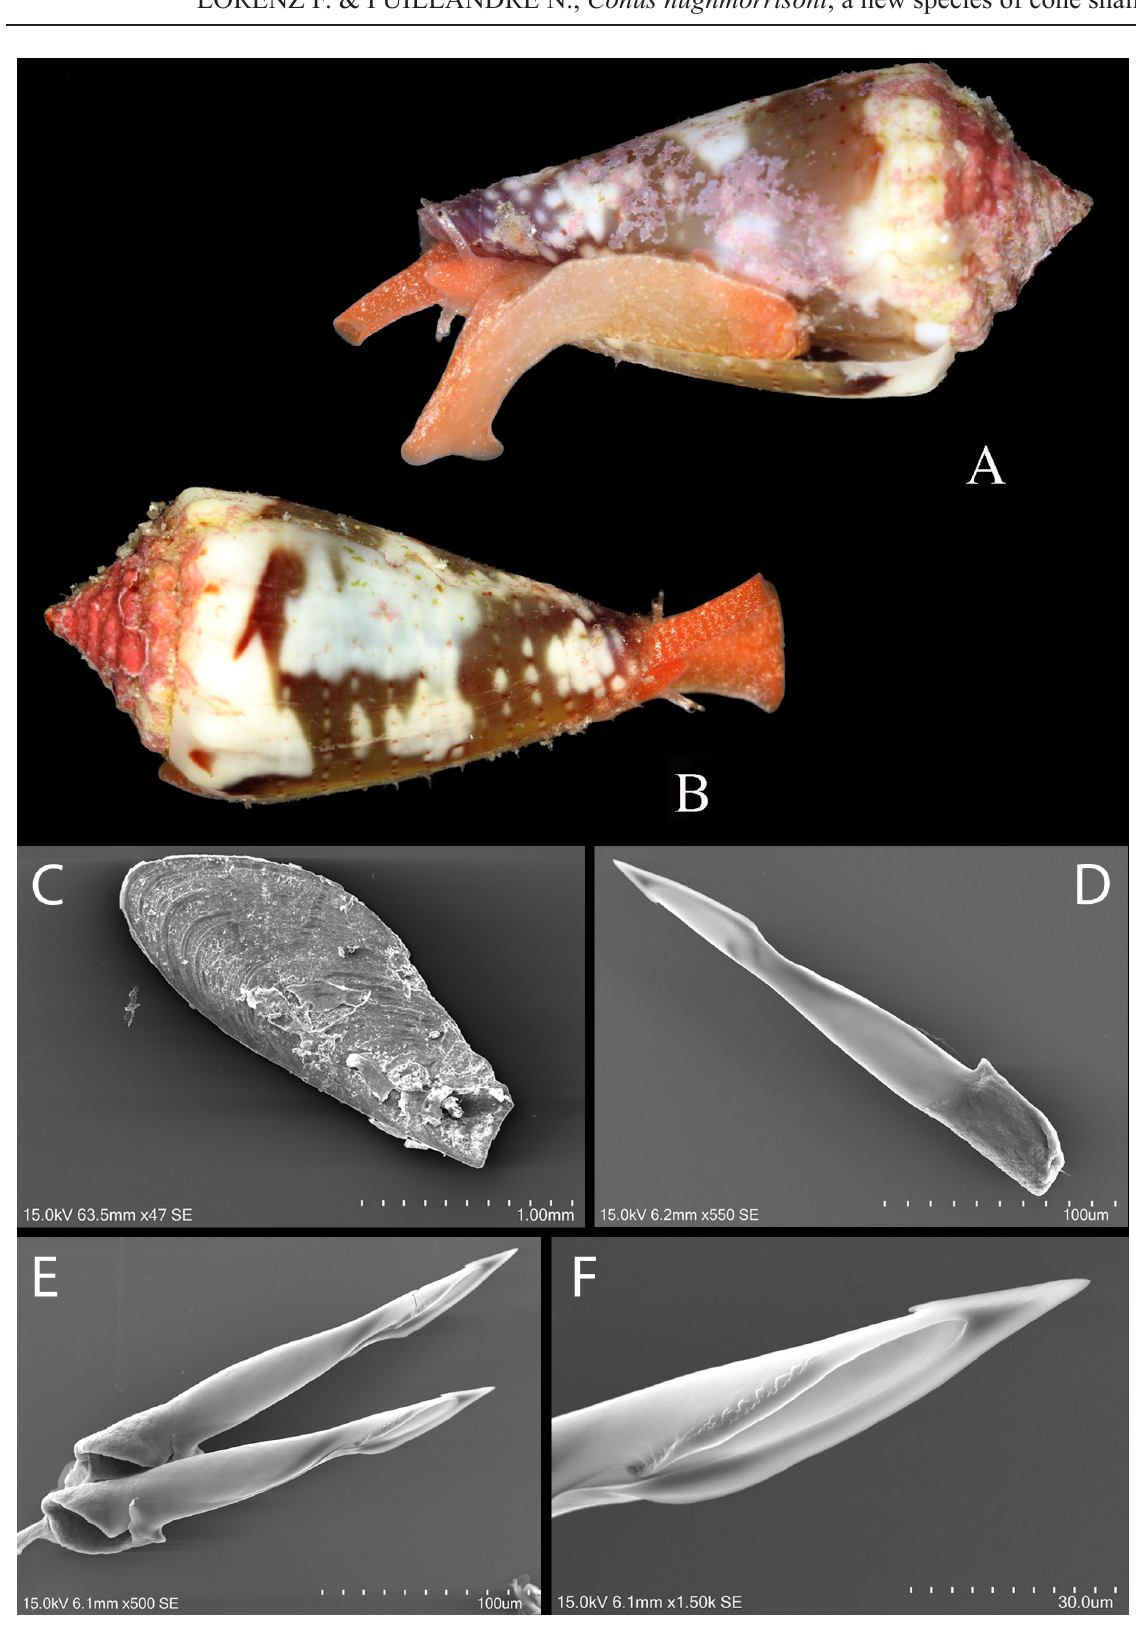
Fig. 3. Conus hughmorrisoni sp. nov. A–B . Paratype 2, 12.55 mm. C . Operculum of paratype 5. D–F . Radula of paratype